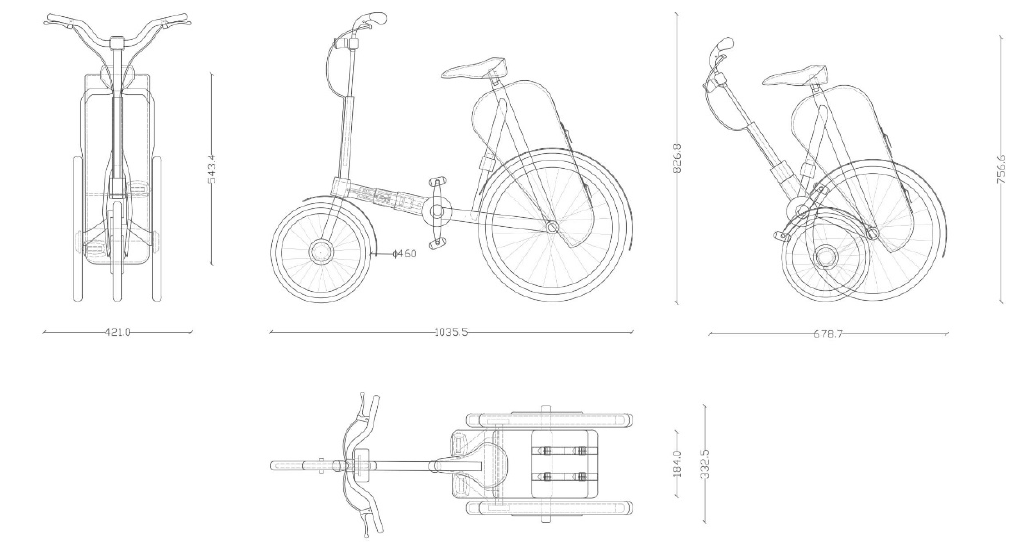
Figure 12. Stylistic references for the retro style—the Graziella Cinzia.